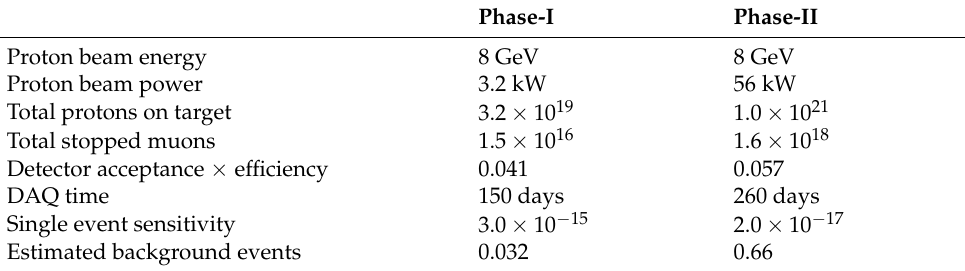
Table 1. Summary of the characteristics of Phase-I and Phase-II of the COMET experiment.